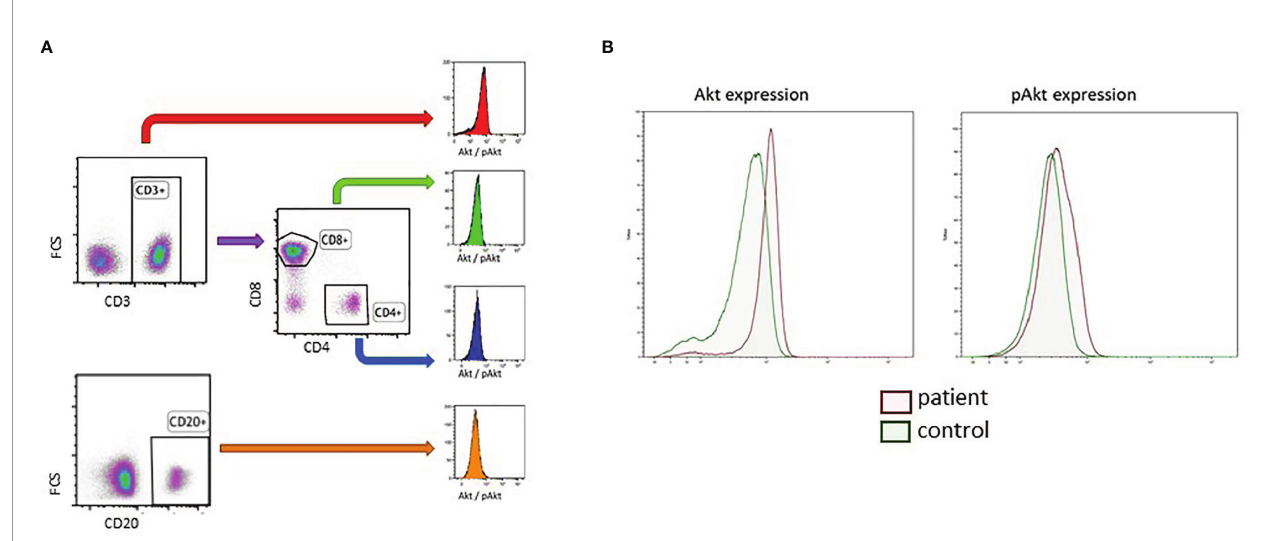
FIGURE 1 | Gating strategy of B cells and T cell subset for the determination of baseline AKT and pAKT expression in DS and healthy controls. (A) Gating strategy of CD3+CD4+ T cells, CD3+CD8+ T cells and CD20+ B-cells. (B) Representative phospho- fl ow plots for AKT and pAKT in unstimulated CD3+ T cells in a DS patient and age matched healthy